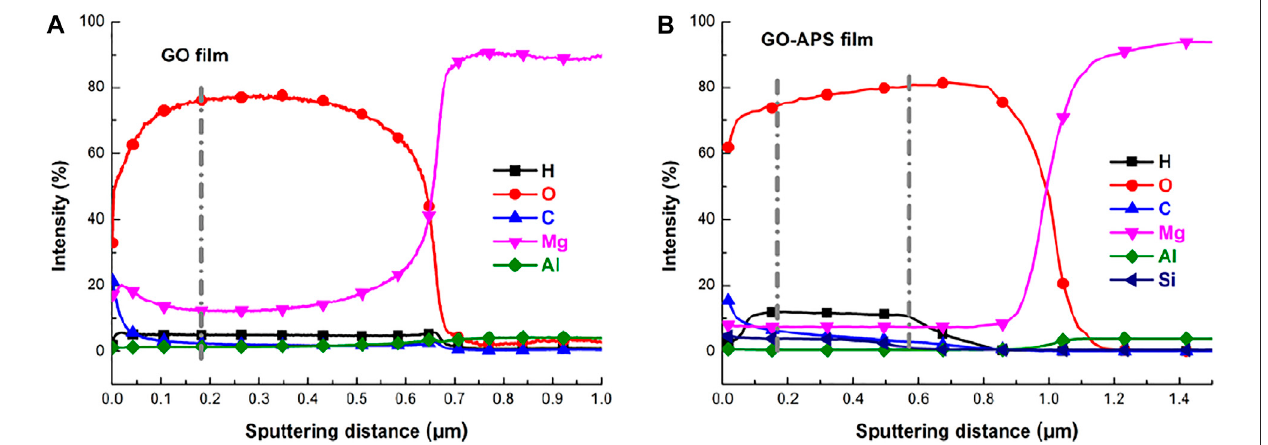
FIGURE8| EIScurvesand fi ttedresultsofbareMgalloyandGO,APS,andGO-APS fi lm – coatedMgalloysamplesafter24 hofimmersionin0.05 MNaClsolution: (A) Nyquist plot; (B) Bode impedance modulus plot; (C) Bode impedance phase angle plot.